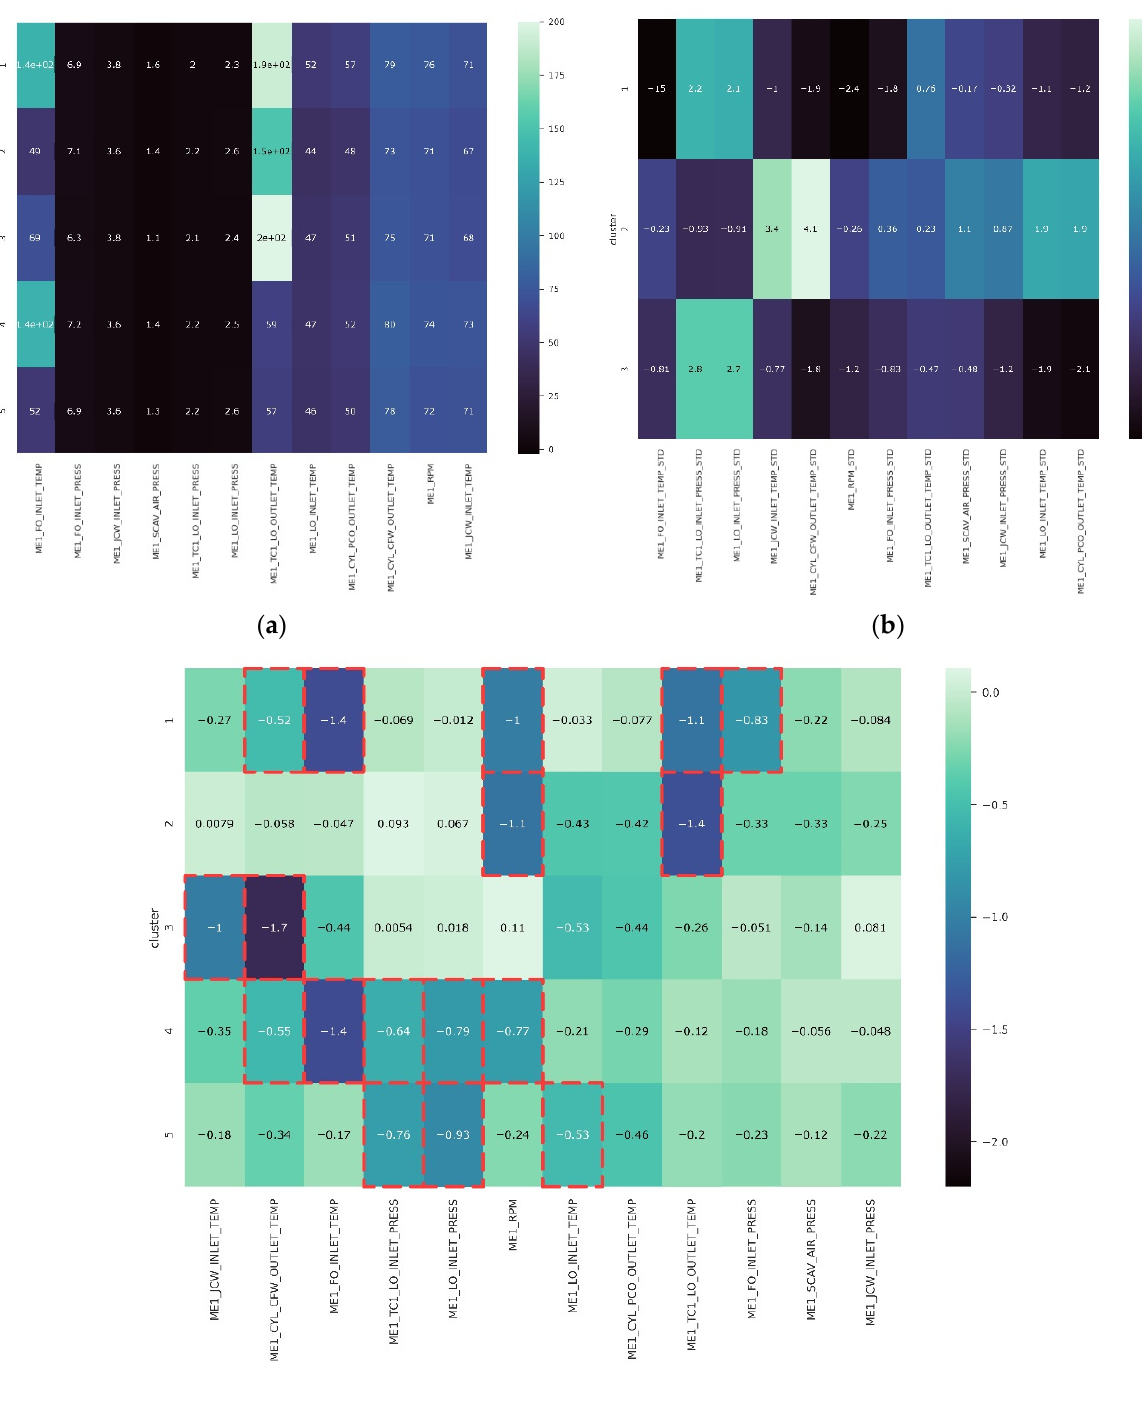
Figure 13. Percentage average silhouette score over clusters.